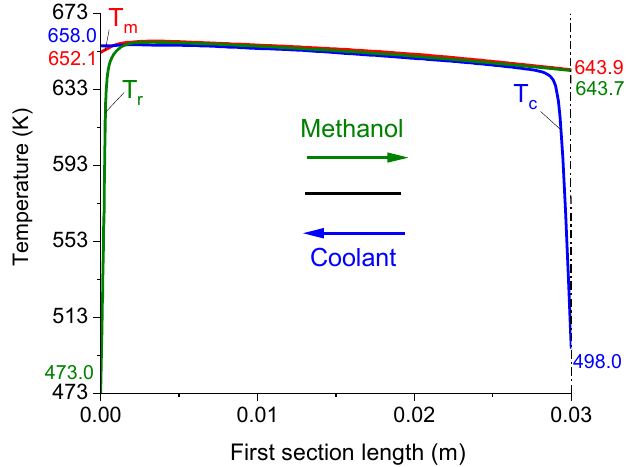
Figure 7. Temperature profiles in the reaction channel, in the catalyst, and in the cooling channels in the first section of the MRHE. Methanol inlet on the left, coolant inlet on the right. Reactant velocity: 2.71 × 10 − 2 m s − 1 . Coolant velocity: 9.0 × 10 − 2 m s − 1 . Reactant inlet temperature: 473 K. Coolant inlet temperature: 498 K. Plate thickness: a = 1.5 mm.